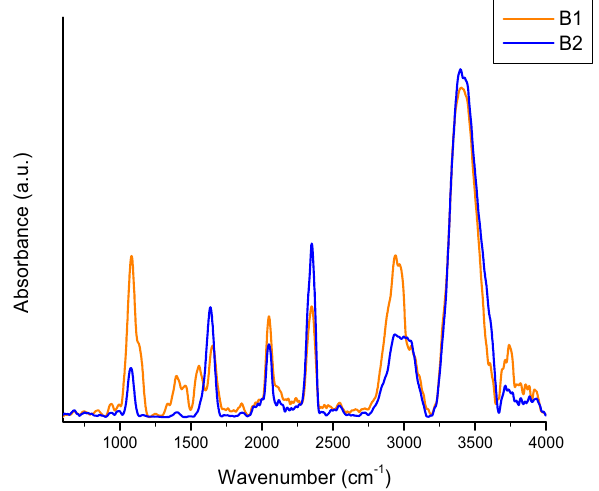
Figure 5. ATR-FTIR spectra for blank 1 (orange) and blank 2 (blue).